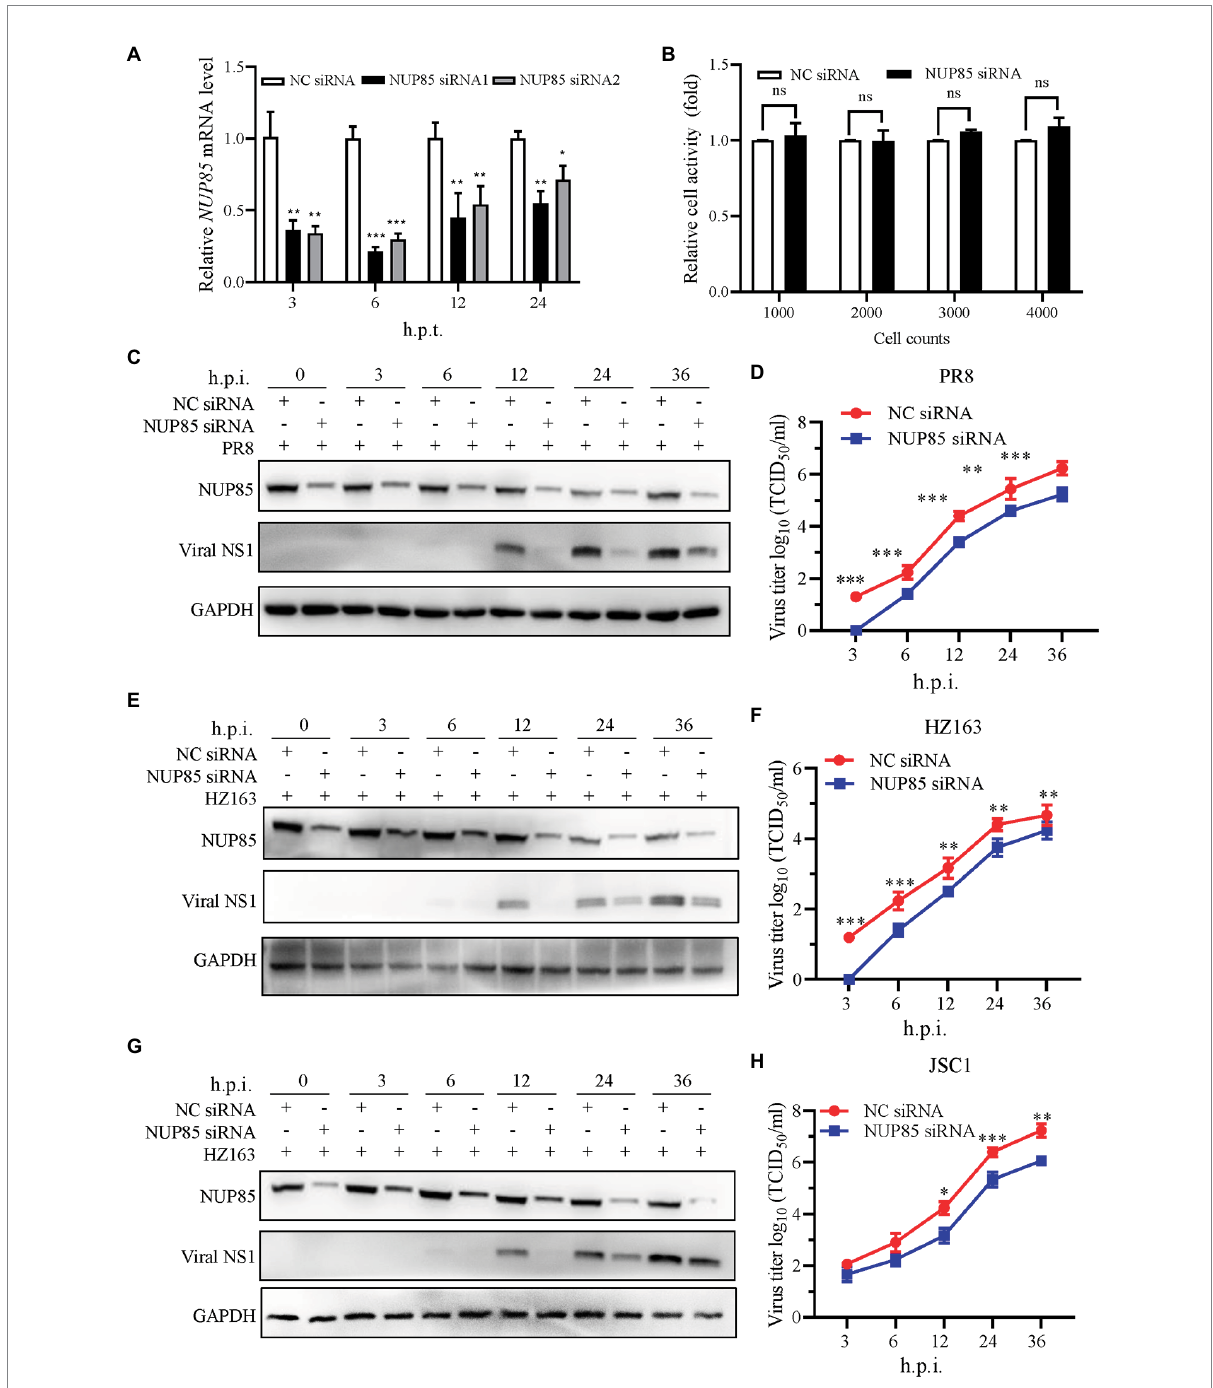
FIGURE 1 NUP85 knockdown suppresses IAV replication. (A) The silencing efficiency of NUP85 -specific siRNAs. A549 cells were transfected with two individual siRNAs targeted to NUP85 (NUP85 siRNA1 and NUP85 siRNA2) or non-target siRNA as negative control (NC siRNA), and the cells were harvested for RNA isolation at 3, 6, 12, and 24 h.p.t., followed by qRT-PCR to detect the relative expression level of NUP85 . (B) The effect of NUP85 siRNA1 on A549 cell viability. Indicated numbers of A549 cells were transfected with NUP85 siRNA1 and NC siRNA for 36 h.p.i. Cell viability was measured by Cell Counting Kit-8 (CCK-8) assay. (C,E,G) The effect of siRNA on the expression of IAV NS1 protein. A549 cells were transfected with NUP85 siRNA and NC siRNA and then infected with H1N1 PR8, H3N2 HZ163, and H9N2 JSC1 (MOI = 0.1). Whole cell lysates were collected at the indicated time points and subjected to Western blot to detect the NUP85 and viral NS1 protein levels. GAPDH was used as an internal control. Images are from one of three independent experiments. (D,F,H) A549 cells were transfected with NUP85 siRNA and NC siRNA and then infected with influenza A virus JSC1, PR8 and HZ163 (MOI = 0.01). Cell supernatants were harvested at 3, 6, 12, 24, and 36 h.p.i. Virus titers were determined by TCID 50 assay on MDCK cells. Data are mean ± SD of three independent experiments. Significance is calculated by unpaired T -test; *indicates p < 0.05; **indicates p < 0.01; *** indicates p <